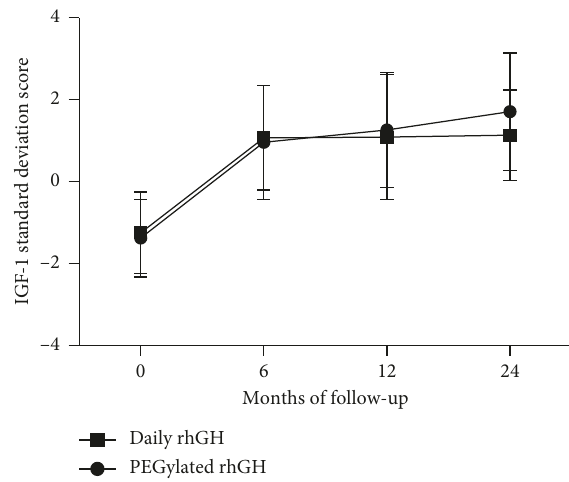
Figure 5: IGF SDS over time in GHD children treated with PEGyated rhGH (weekly) or daily rhGH (daily) for 24months. Values represent mean ± SD. Table 2: Treatment-related adverse events reported in each